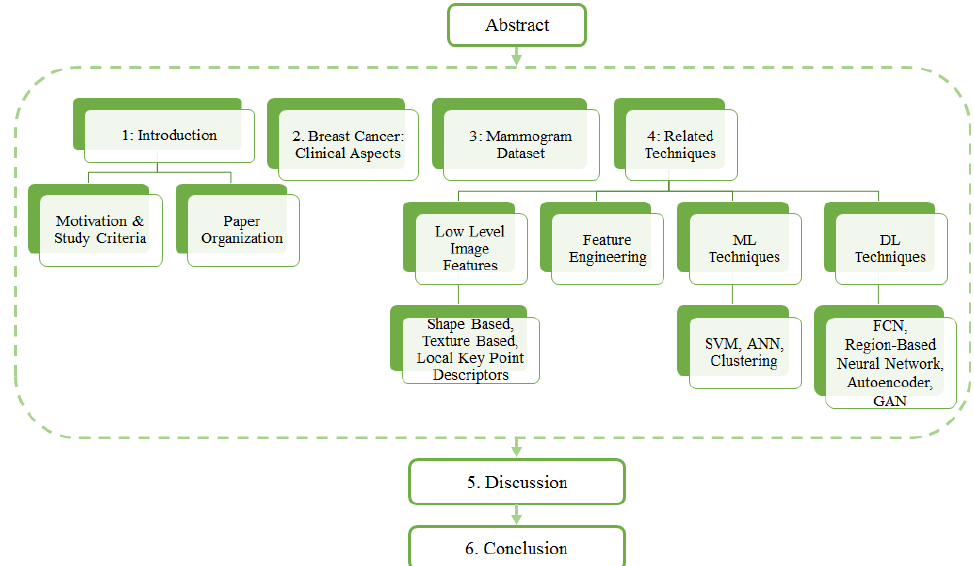
Figure 1. Organization of